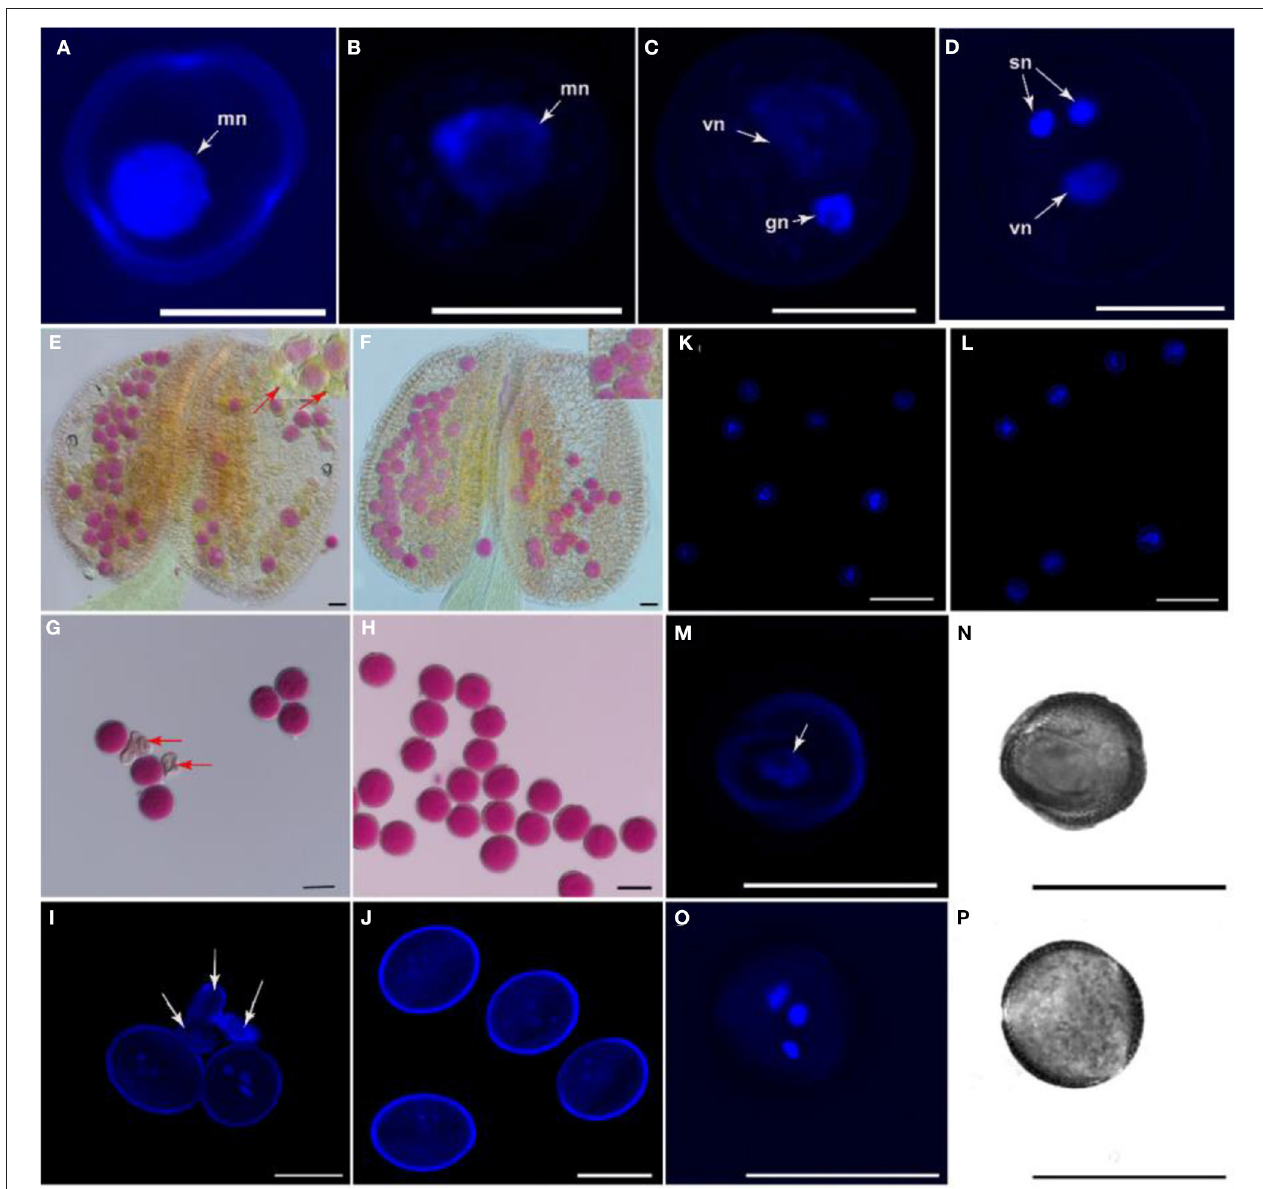
FIGURE 3 | Morphology and viability of apg2-1 + / − mutant pollen grains. (A–D) The nuclear constitution of WT pollen grains through microgametogenesis developmental stages. Nuclei are indicated by arrows; mn, microspore nucleus; vn, vegetative nucleus; gn, generative nucleus; sn, sperm neclei. Bars = 10 µ m. (E,F) Pollen viability by means of Alexander’s staining in anthers from WT and ap1g2-1 + / − , respectively. Arrows indicate impaired pollen grains. (G,H) Alexander’s staining of mature pollen grains from WT and ap1g2-1 + / − , respectively. Arrows indicate impaired pollen grains. (I,J) 40,6-Diamidino-2-phenylindole (DAPI) staining of pollen grains from buds at Stage 13 in WT and ap1g2-1 + / − , respectively. Arrows indicate impaired pollen grains. (K,L) DAPI staining of microspores from buds at Stage 9 in WT and ap1g2-1 + / − , respectively. (M,O) Nuclear constitution by means of DAPI staining in pollen grains in buds at Stage 12 from WT and ap1g2-1 + / − , respectively. Arrows indicate nuclei. (N,P) Bright field images of (M,O) , respectively. Bars = 20 µ m in (E–P)